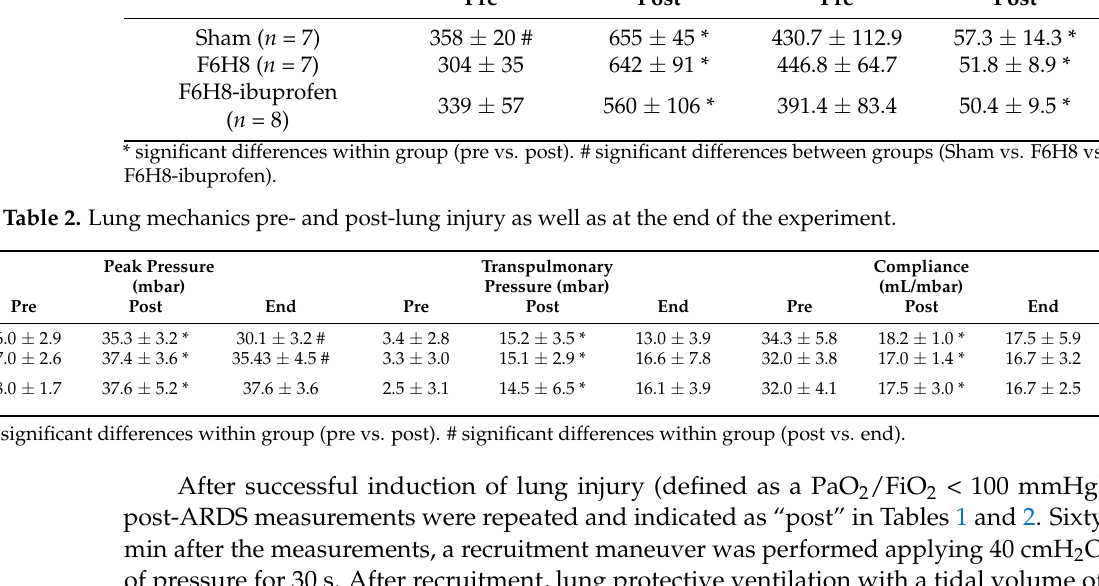
Table 1. Extravascular lung water (EVLW) and PaO 2 /FiO 2 ratio pre- and post-lung injury to verify the successful induction of an acute respiratory distress syndrome (ARDS). EVLW PaO2/FiO2 Ratio Group (mL) (mmHg) Pre Post Pre Post Sham ( n = 7)